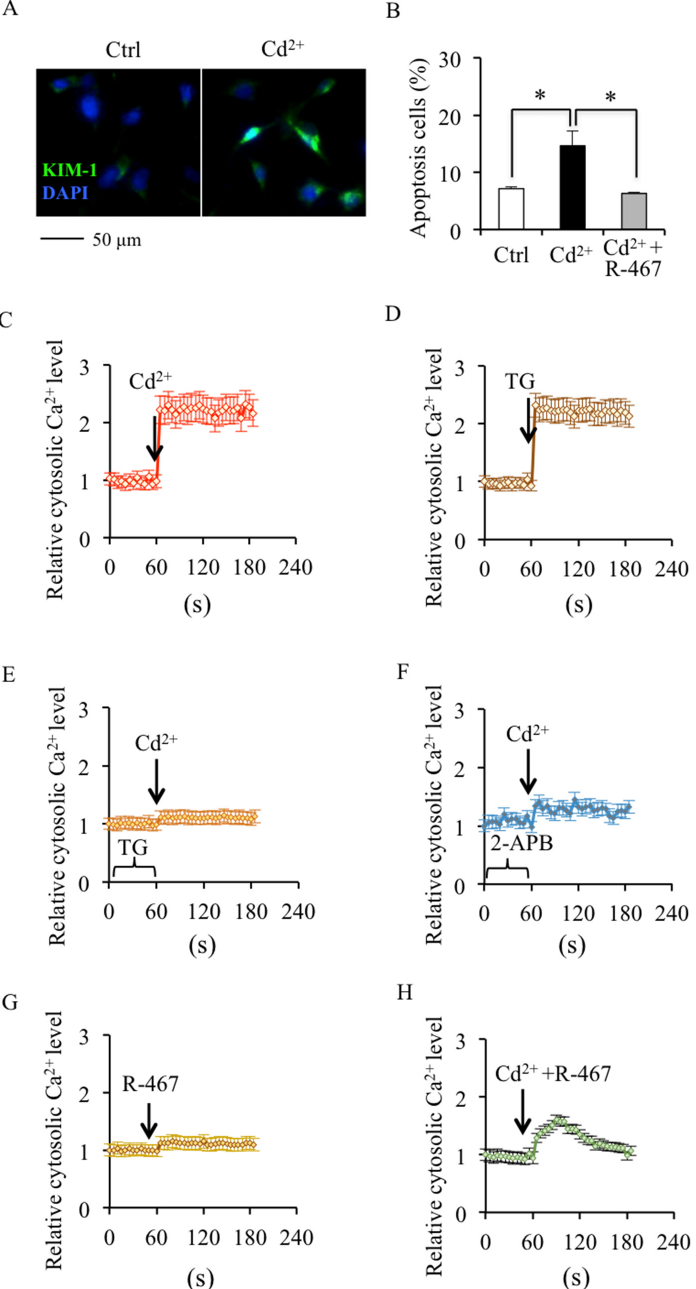
Figure 1. Effects of NPS R-467 on Cd 2+ -induced apoptosis and dysregulated transient cytosolic Ca 2+ homeostasis. ( A ) Cd 2+ induced the expression of kidney injury biomarker KIM-1 in mRTEC. KIM-1: Green, DAPI: Blue. ( B ) Effects of R-467 on Cd 2+ -induced apoptosis of mRTEC cells. After being treated with CdCl 2 (5 µ M) or CdCl 2 (5 µ M)+R-467 (1 µ M) for 24 h, the apoptosis of mRTEC cells was determined by flow cytometry staining by Annexin V-FITC/PI. The apoptosis percentage was calculated. ( C – H ) Transient effects of Cd 2+ and R-467 on cytosolic Ca 2+ levels in mRTEC cells. After treated with CdCl 2 (5 µ M) or CdCl 2 (5 µ M)+R-467 (1 µ M) or pretreated with TG (0.1 µ M) and 2-APB (50 µ M), the cytosolic Ca 2+ level changes in mRTEC cells were determined by Fura-2/AM immediately. 2-APB: inhibitor of ER Ca 2+ release channel IP 3 R, R-467: Calcimimetics, activator of Calcium sensing receptor, TG: inhibitor of SERCA. Results are presented as mean ± SD ( n = 4 well cells/group). * Statistical significance between control and treatments, or between treatments, p < 0.05, using one-way ANOVA followed by Duncan’s multiple range